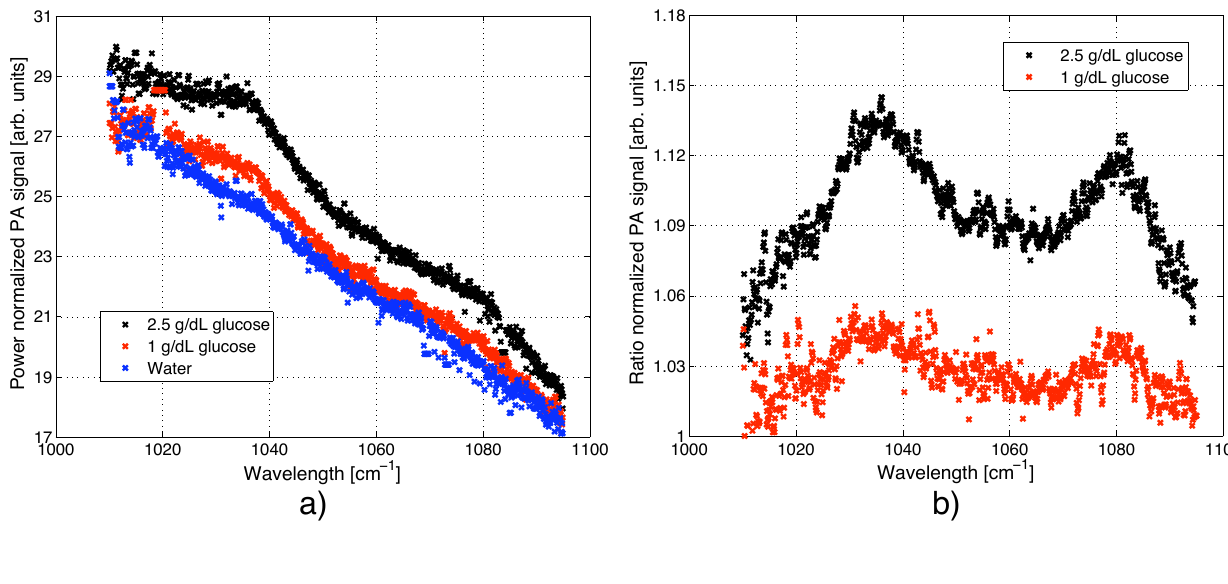
Figure 6. PA spectrum of an aqueous solution with 0, 1.0 and 2.5 g/dL glucose. The QCL was tuned via the external grating and modulation with a frequency of 117 Hz. ( a ) The PA signal was normalized with the output power of the QCL. The wavelength dependent transmission of the fiber was not taken into account, which results in a reduced PA signal for larger wavenumbers; ( b ) Taking the ratio between the glucose and water spectrum reveals the two glucose absorption peaks at 1,034 and 1,080 cm − 1